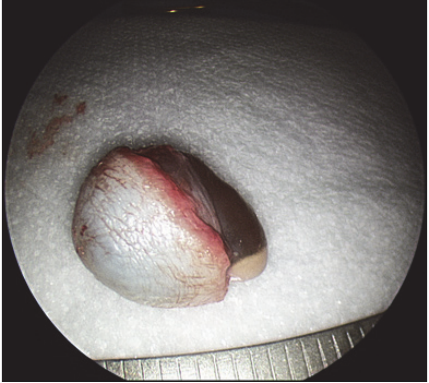
Figure 3: A bluish smooth cystic lesion is excised with some overlying skin. The lesion contains brown